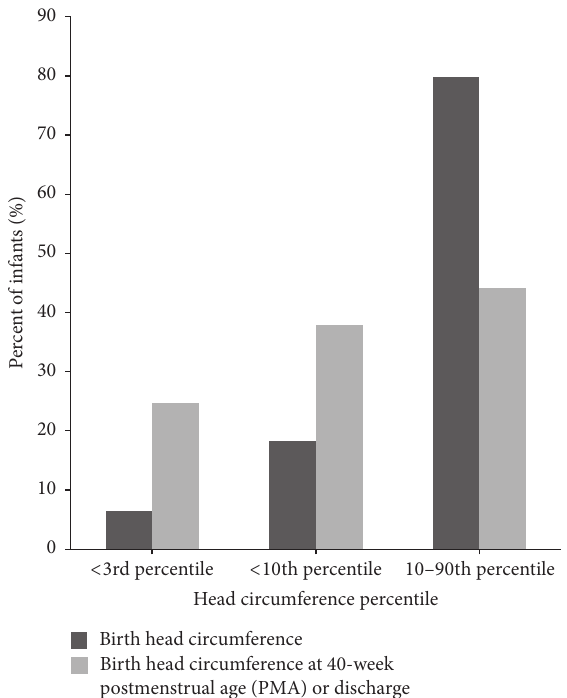
Figure 3: Length percentile ranking from birth to 40-week PMA or discharge.